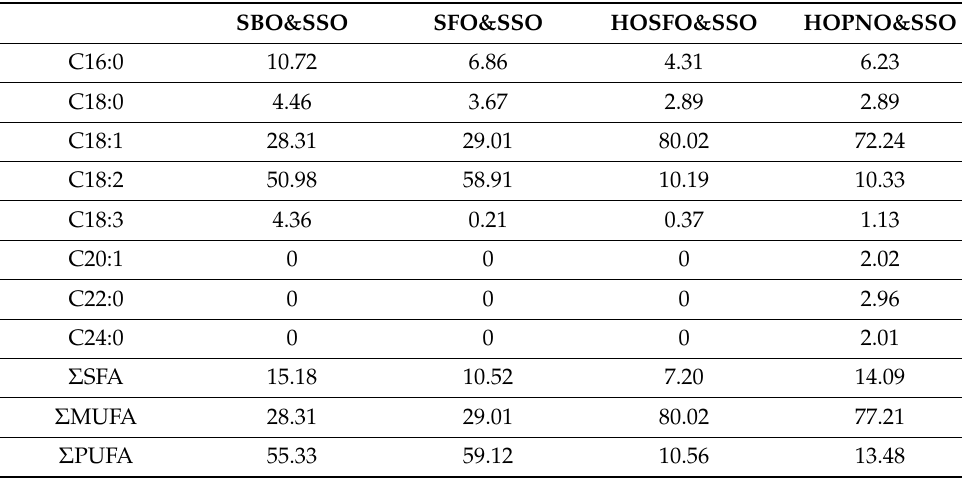
Table 1. Fatty acid compositions (%) of different sesame seed oil